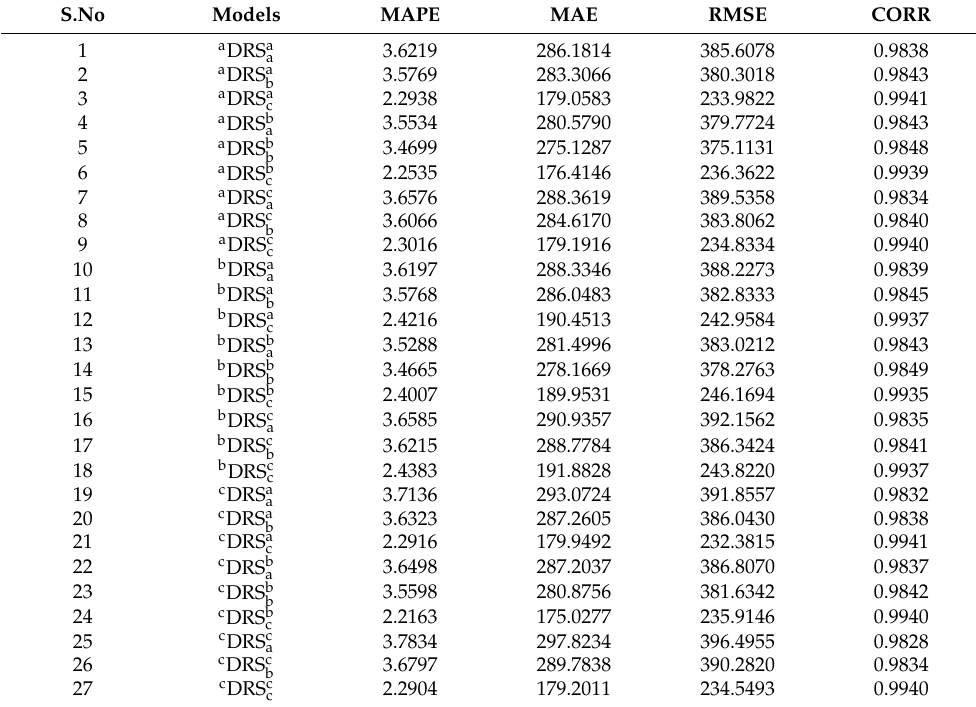
Table 2. Pakistan’s electricity consumption (kWh): out-of-sample one-month-ahead average forecast error for all combined models with the DRS